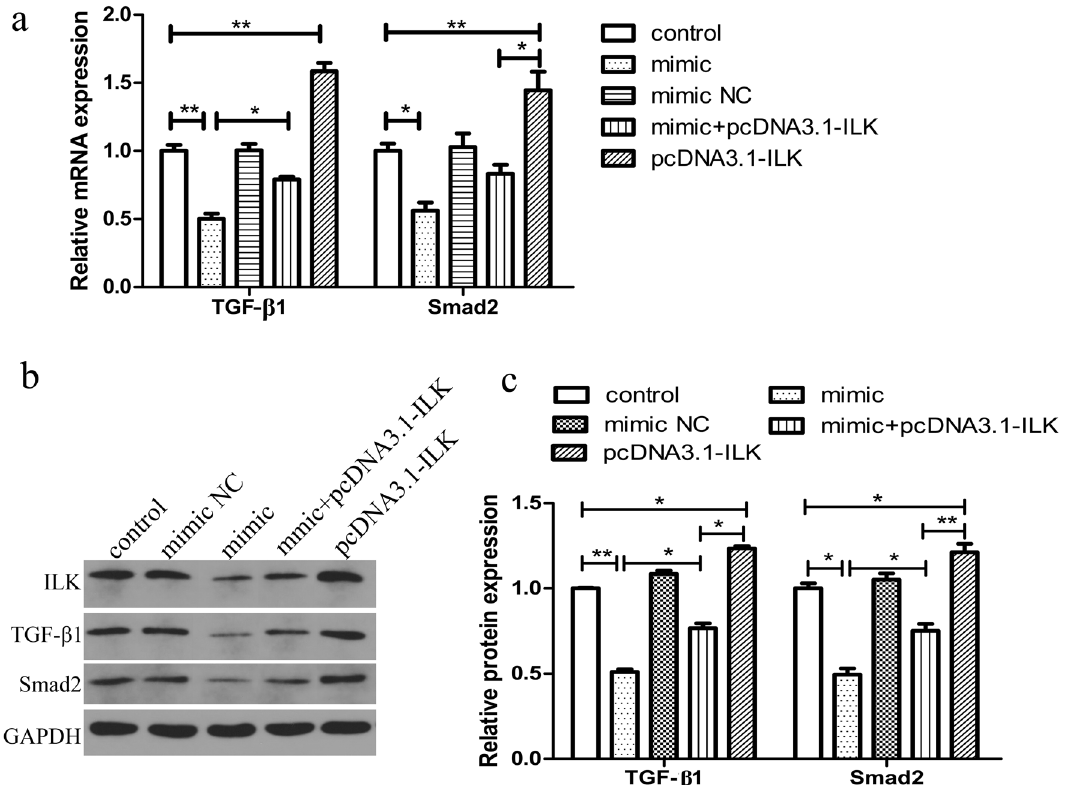
Figure 4. Effects of miR-542-3p and ILK on expression of TGF-β1/Smad2 pathway. ( a ) qRT-PCR analysis of TGF-β1and Smad2 mRNA levels. ( b, c ) Representative western blots showing TGF-β1 and Smad2 protein levels in HESCs cell after co-transfected with pcDNA3.1-ILK vector, together with/without miR-542-3p mimic or mimic NC. *p < 0.05, **p < 0.01. Values are expressed as mean ± SD of three independent